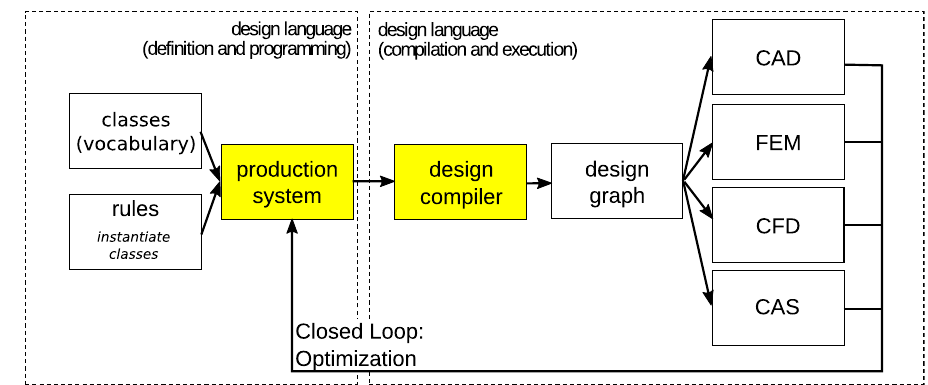
Fig. 2 Information architec- ture of a graph-based design